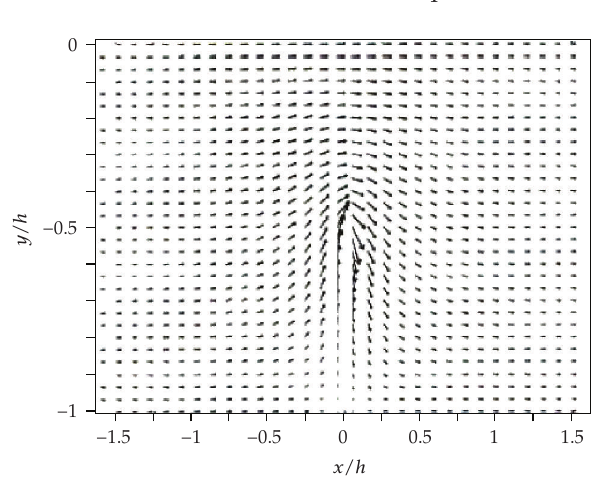
Figure 4: The field velocity h (cid:8) 20cm, l (cid:8) 10cm, and ε (cid:8) 0 . 6 .